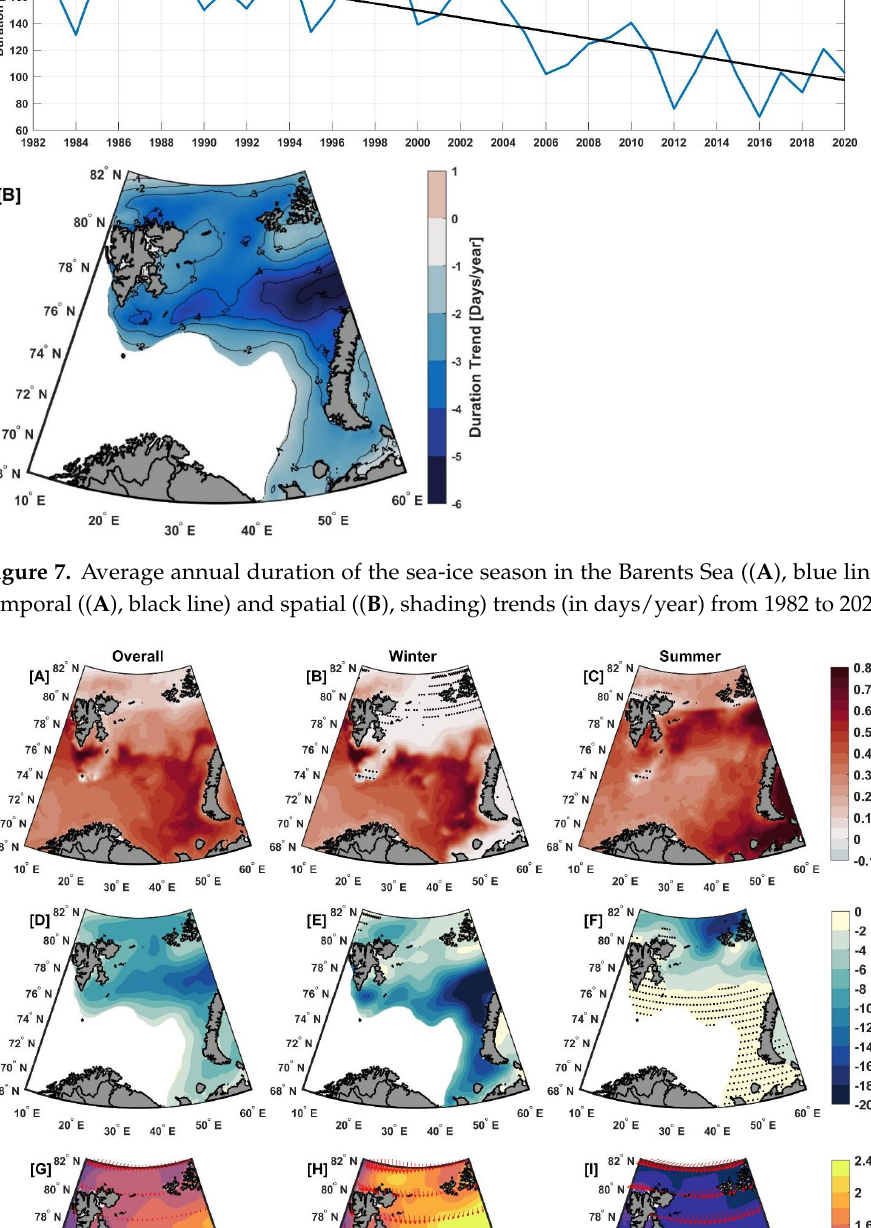
Figure 6. Average duration of sea-ice season (in Days) for ( A ) the whole period (1982 – 2020), ( B ) the beginning (1982), and ( C ) the end (2020) year of the period.